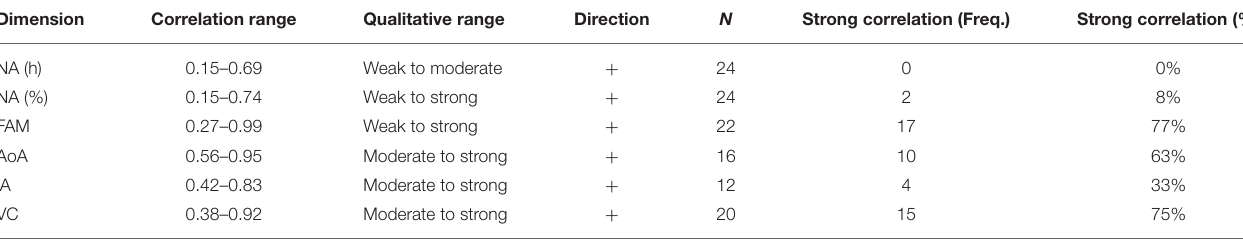
TABLE 4 | Descriptive information of cross-country comparisons of the dimensions across studies. Dimension Correlation